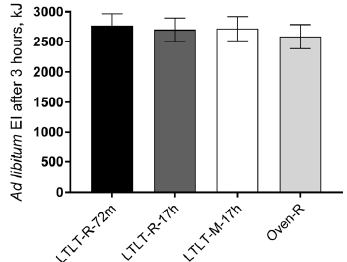
Figure 1. Ad libitum energy intake (mean ± standard error of the mean (SEM), n = 37) three hours after